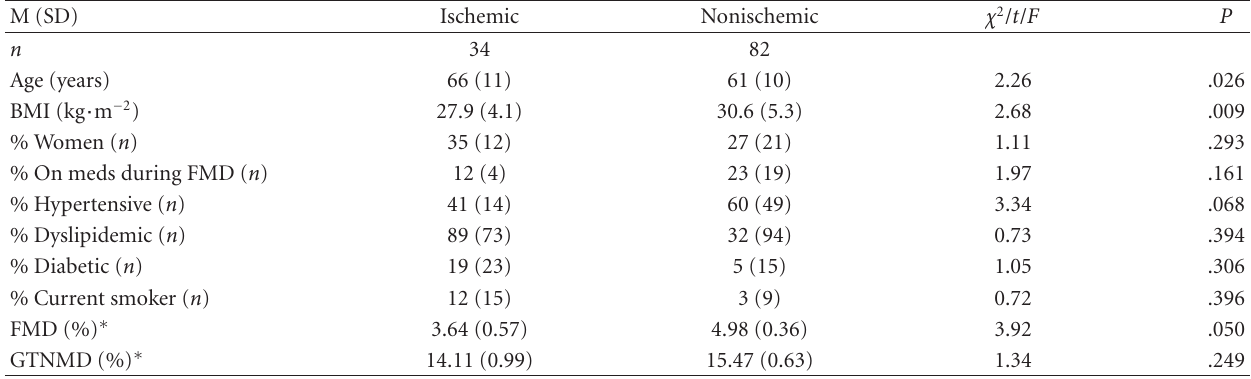
Table 1: Clinical and demographic variables for those patients with and without exercise-induced ischemia.